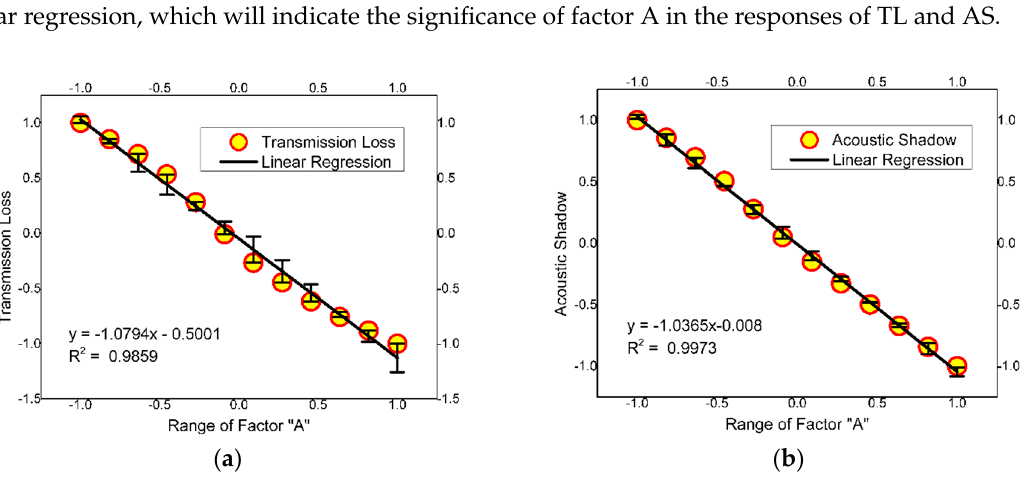
Figure 9. Comparison of the significance effects for factor “A”—Height of the noise barrier using the Modified Profile Method (MPM) with the application of Linear Regression: ( a ) Transmission Loss as a response; ( b ) area of the acoustic shadow as a response.